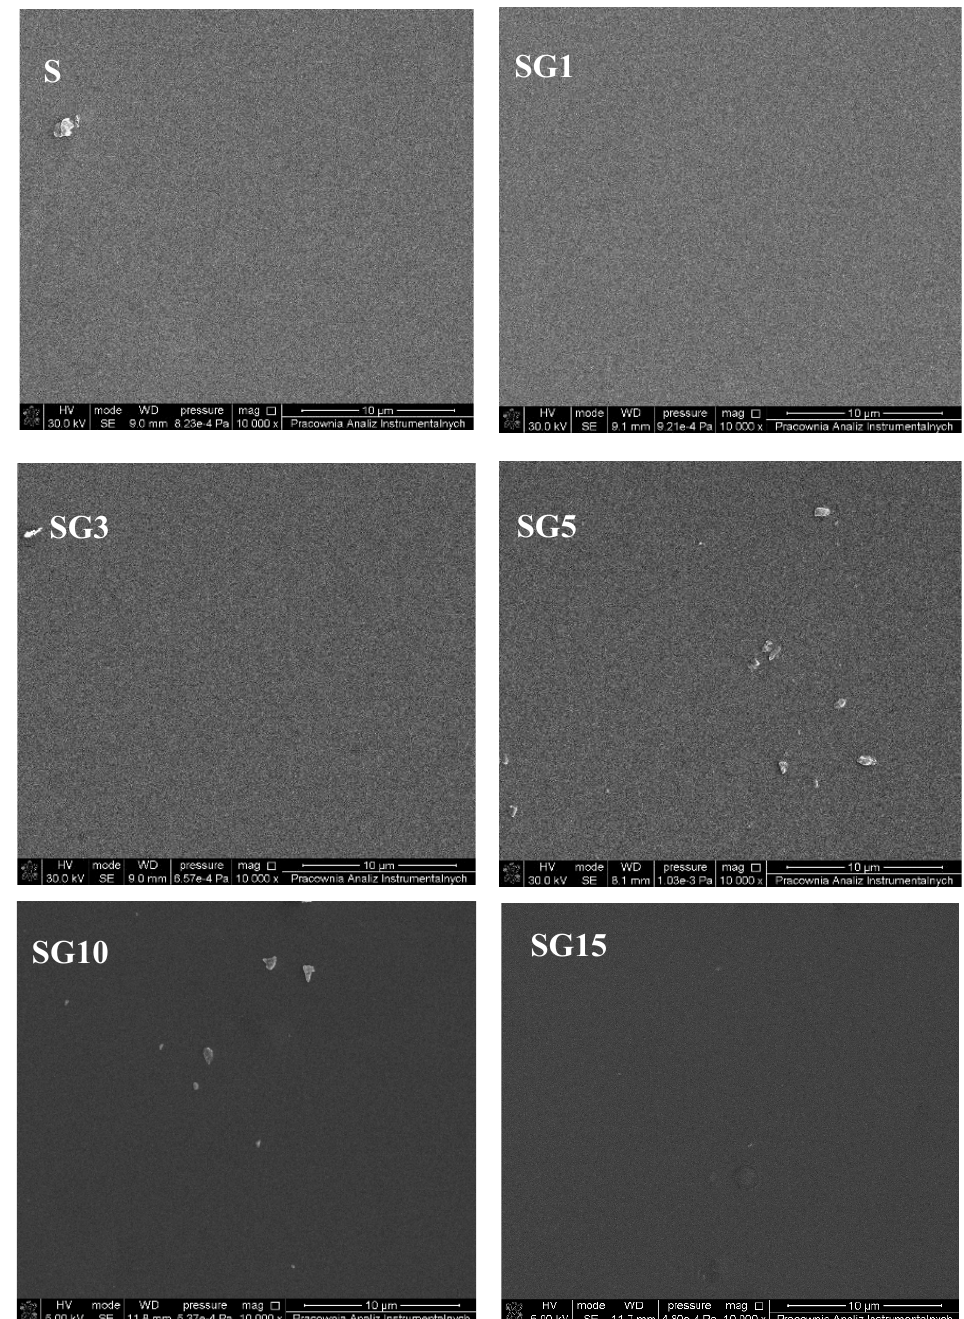
Figure 4. SEM images of elastomer and polymer matrix filled with graphite. The comparison of surface morphology of PDMS and its composites filled with shungite has been presented in Figure 5. The addition of shungite in the range between 1 and 10 wt.% does not cause significant changes in the morphology of the analyzed materials. The surface of composites SSh1, SSh3, SSh5, and SSh10 seems to be uncovered by any cracks, holes, or pores. However, it can be clearly observed that in the case of the sample containing 15 wt.% of shungite, the aggregates of filler cause differentiation of the surface morphology of the obtained material.